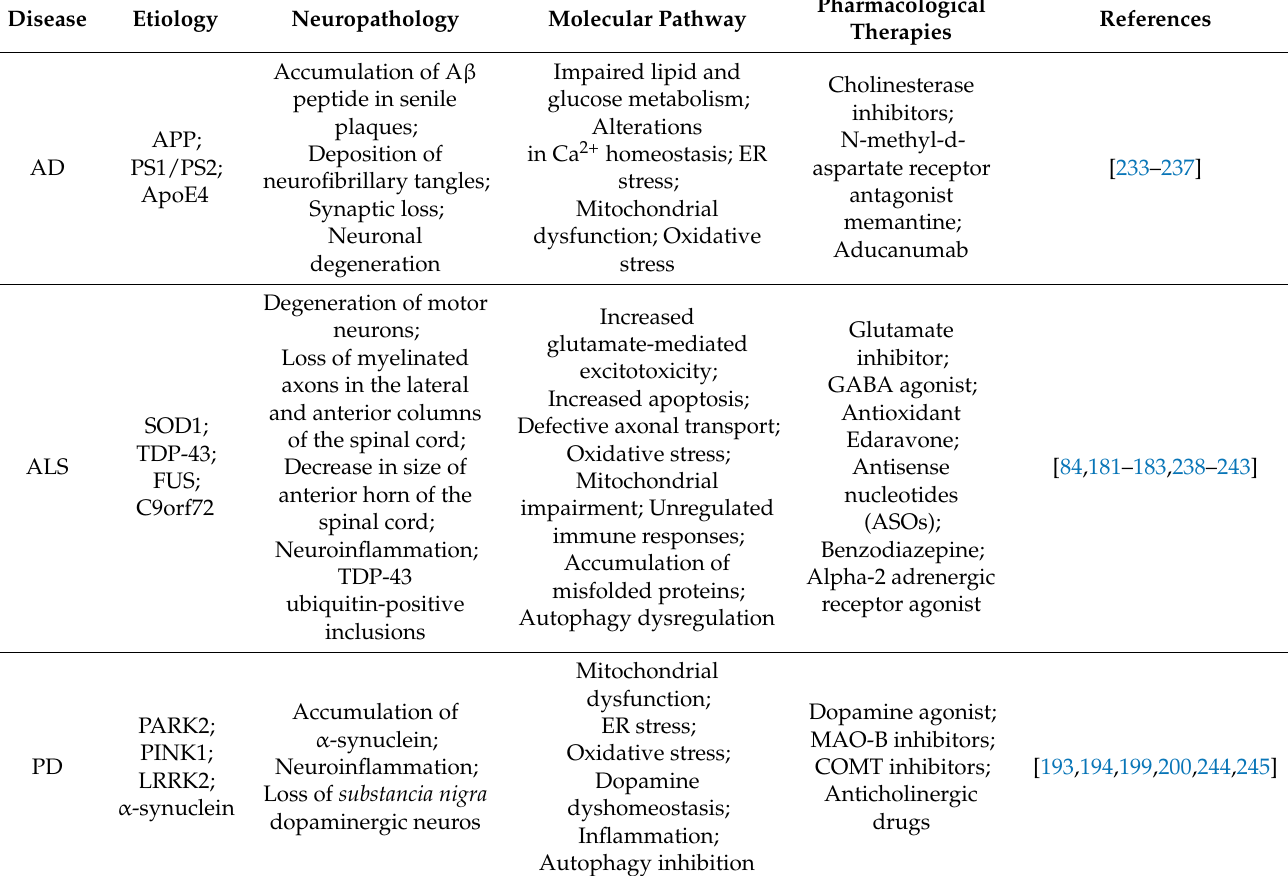
Table 1. Description of neurodegenerative disorders, AD, ALS, and